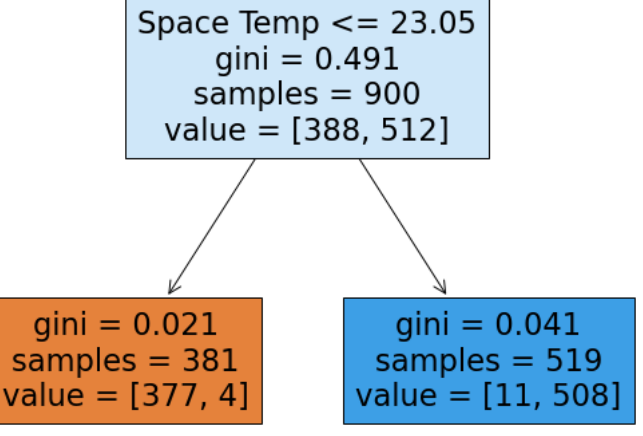
Figure 13. Terminal Unit DT.